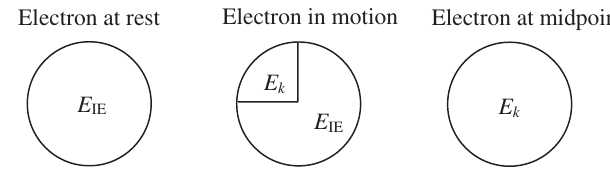
FIG. 2. Example energy pie charts (here E action